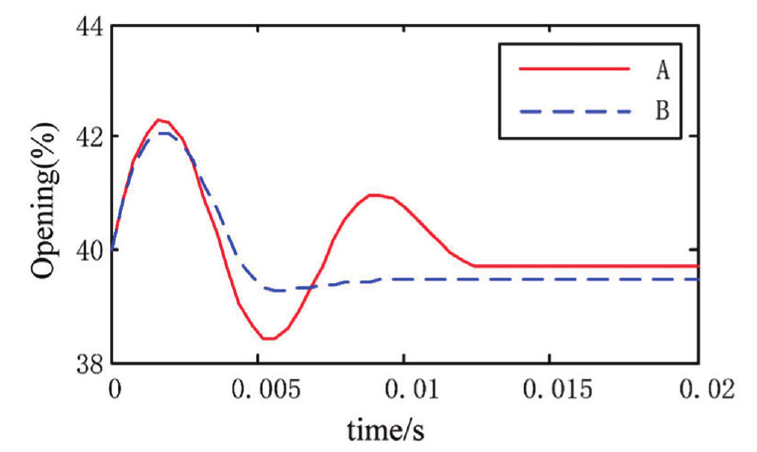
Figure 10. Valve position responses of different switching points.